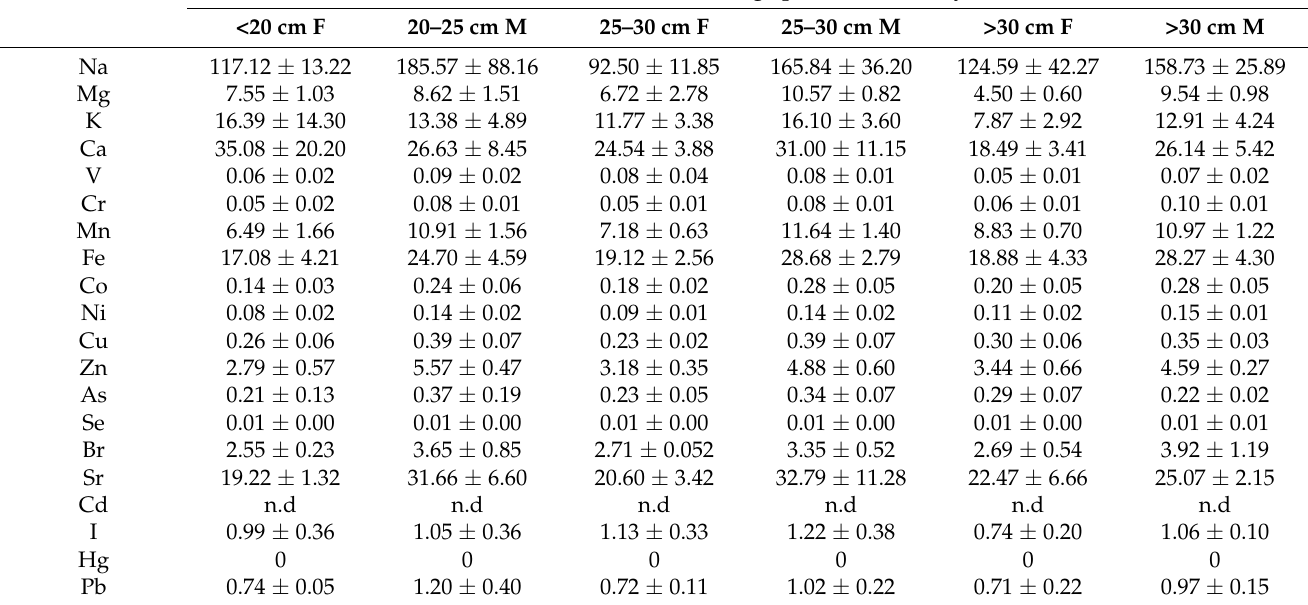
Table 2. Mineral Composition (mg/100 g) of 6 different profiles of F. vesiculosus , comprising 4 growth stages and both genders. ( n = 3). n.d: not